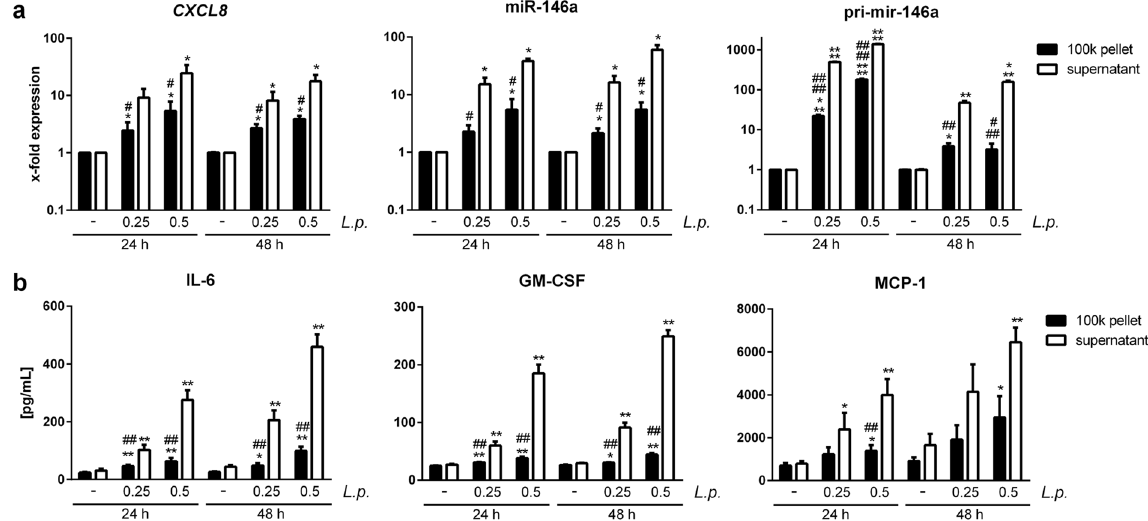
Figure 2. L . pneumophila induced cytokines elicit a pro-inflammatory response in non-infected A549 cells. ( a , b ) Response of A549 cells to vesicle-free supernatant or 100 k pellet from L . pneumophila -infected THP-1 cells. A549 cells were stimulated with vesicle-free supernatant or 100 k pellet from THP-1 cells infected with L . pneumophila ( L . p .) at an MOI of 0.25 and 0.5, respectively, for 24 h. A549 cells were incubated as indicated for 24 or 48 h, respectively. RNA and supernatant were collected. ( a ) qPCR was performed for expression of CXCL8 , miR-146a and pri-mir-146a. ( b ) Magnetic multiplex ELISA was performed. Results for IL-6, GM-CSF and MCP-1 are shown. Data are shown as mean + SEM of at least three independent experiments. * p <